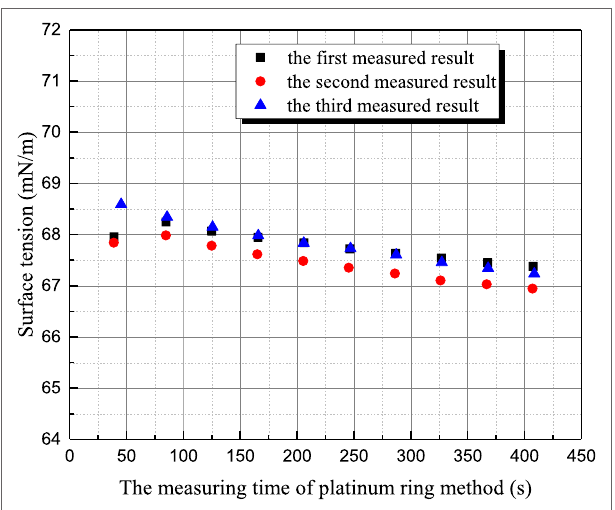
FigUre 6 | The relationship of measured surface tension by maximum bubble pressure method (sodium hydroxide concentration is 1 mol/L).